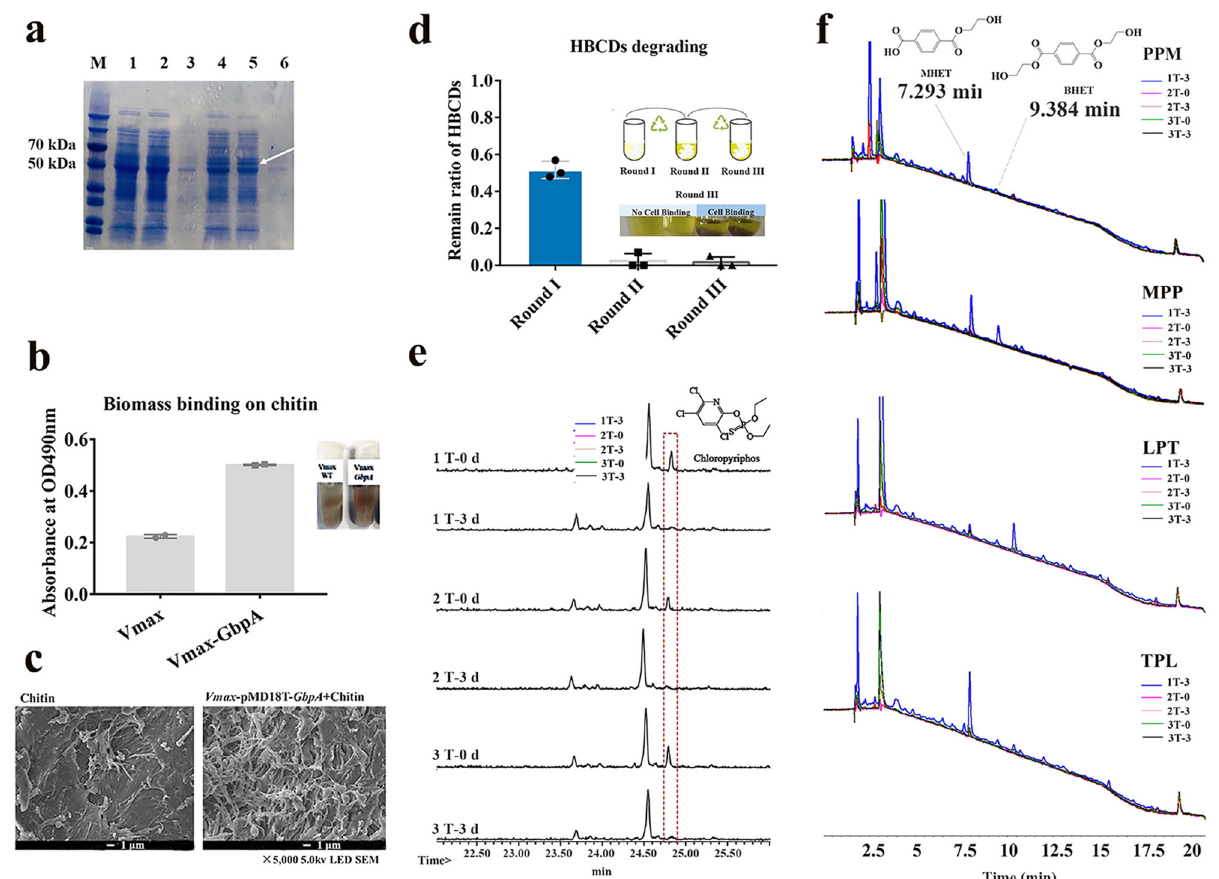
Fig. 5 Environmental and ecological safety. a Analysis of the expression of the chitin-binding protein GbpA by SDS-PAGE. M, protein marker; lane 1 – 3, crude enzyme, supernatant, precipitate of strain Vmax; lane 4 – 6, crude enzyme, supernatant, precipitate of strain Vmax-GbpA. b Measurement of biomass binding on chitin by a 3-(4,5)-dimethylthiahiazo (-z-y1)-3,5-di- phenytetrazoliumromide (MTT) assay kit. Error bars are standard error of mean. c Morphology of the bio-anchored chitin under scanning electron microscope (SEM) S3400II (Hitachi, Japan) with an accelerating voltage of 20 kV. d – f Veri fi cation of the recovery rate and degradation effect of the chitin- fi xed strains for HBCDs, CP, and mPET,